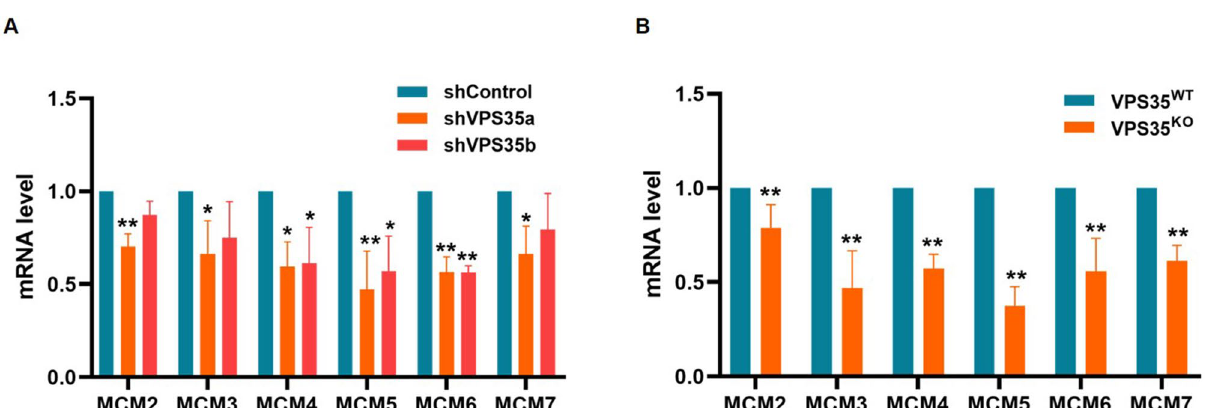
Figure 4. Evaluation of mRNA expression of MCM2-7 genes by qRT–PCR. ( A ) Basal mRNA expression of MCM genes was analyzed in HeLa cells stably expressing the indicated shRNA by qRT–PCR. The value of each gene expressed in shControl cells was normalized to 1, and that in shVPS35 cells was expressed as the mean ± S.D. derived from three independent experiments. ( B ) Basal mRNA expression of MCM genes was analyzed in VPS35 WT and VPS35 KO HeLa cells by qRT–PCR. The value of each gene expressed in VPS35 WT cells was normalized to 1, and that in VPS35 KO cells expressed was as the mean ± S.D. derived from three independent experiments. *, p < 0.05 vs. shControl or VPS35 WT ; **, p < 0.01 vs. shControl or VPS35 WT